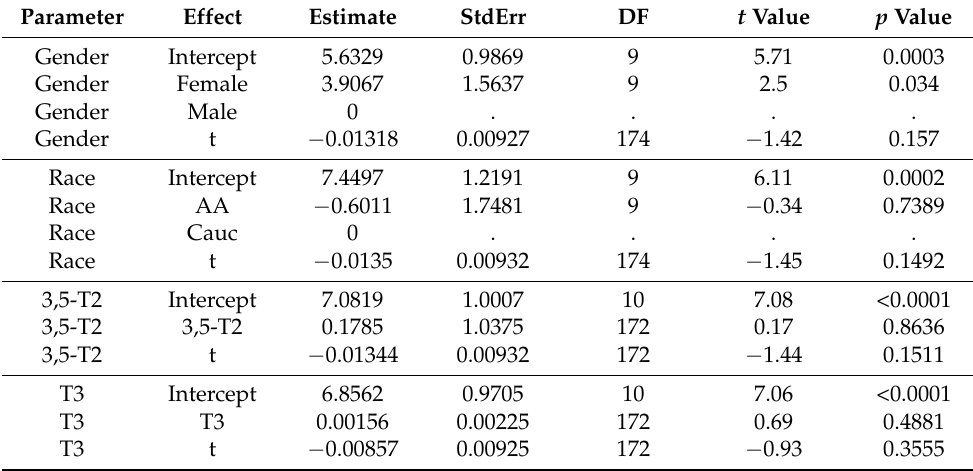
Table A2. Analysis of 3-T1AM levels: Healthy